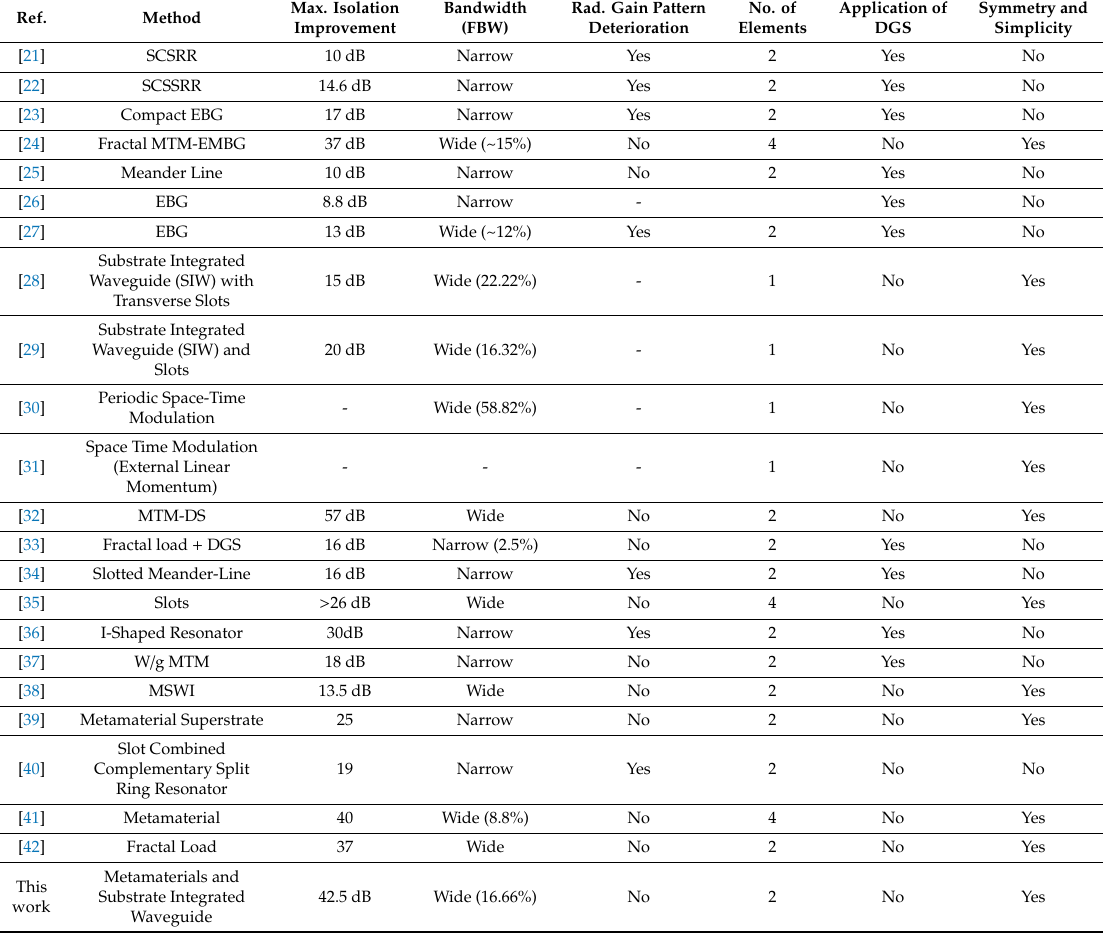
Table 3. Performance parameters of the proposed lw array antennas in comparison with the recent papers.